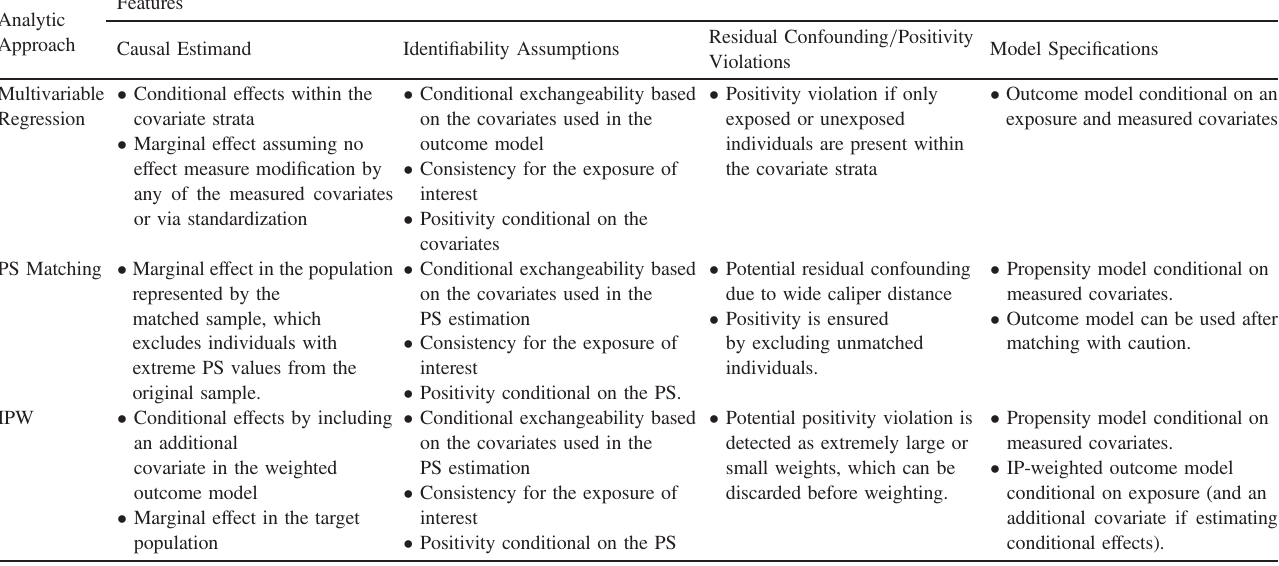
Table 1. Comparison of multivariable regression, propensity score matching, and inverse probability weighting by the underlying assumptions